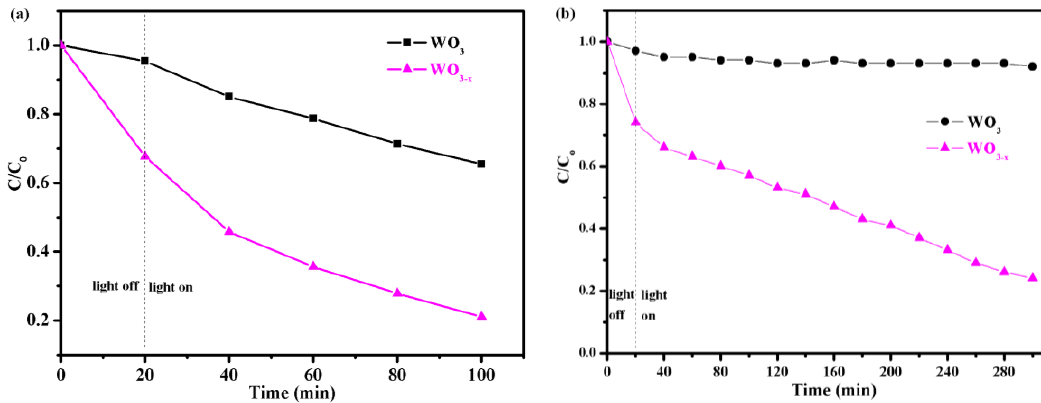
Figure 6. ( a ) UV light photocatalytic degradation of rhodamine B (RhB) and ( b ) visible-light photocatalytic degradation of RhB by the prepared photocatalysts.